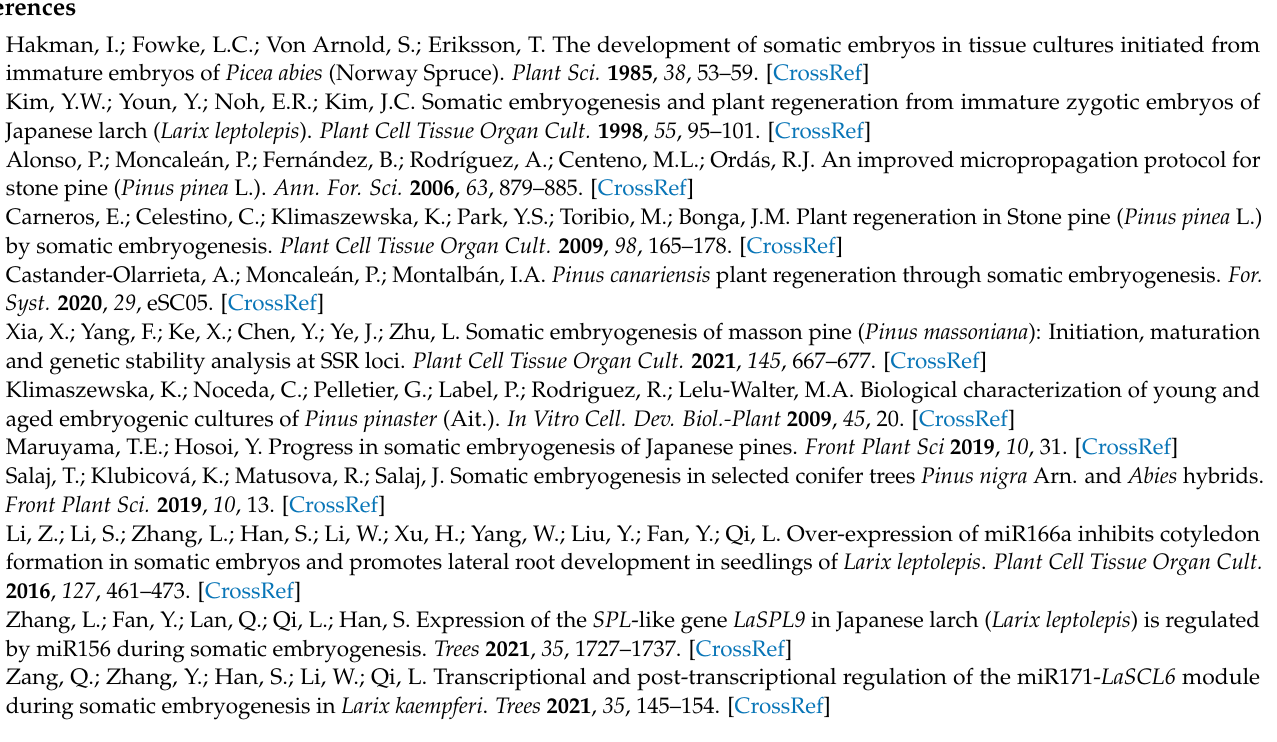
Table S1: The mediums used in L. keampferi somatic embryogenesis, Table S2: Promoter elements of LaCDKB1;2 , Data S1: The sequence information of LaCDKB1;2